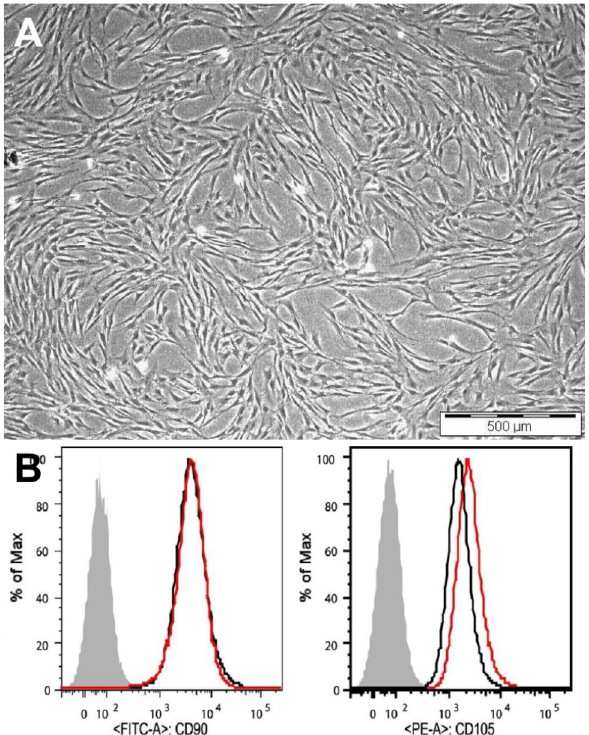
Figure 7. Characterization of isolated Human Dental Pulp Stem Cells (hDPSCs) ( A ) Representative phase contrast microscopic image of hDPSCs. ( B ) Flow cytometry histograms of specific markers (CD90 and CD105) expressed in custom prepared hDPSCs extracted by enzyme digestion method showed a purity of 96%.